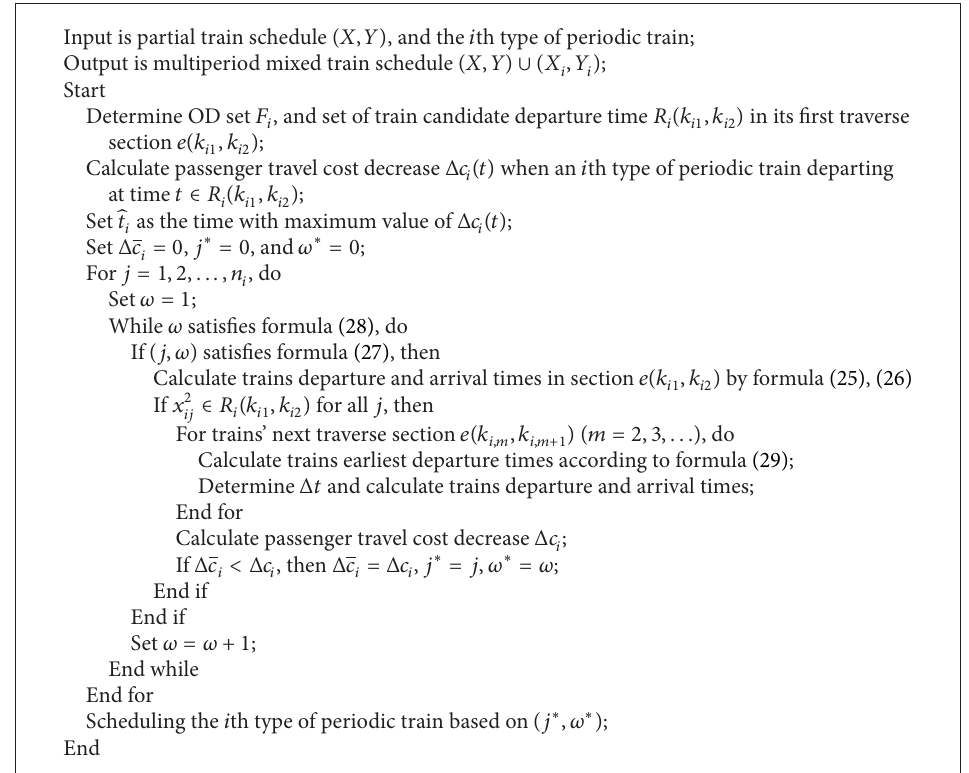
Algorithm 2: Scheduling the 𝑖 th type of periodic train based on a given train schedule.